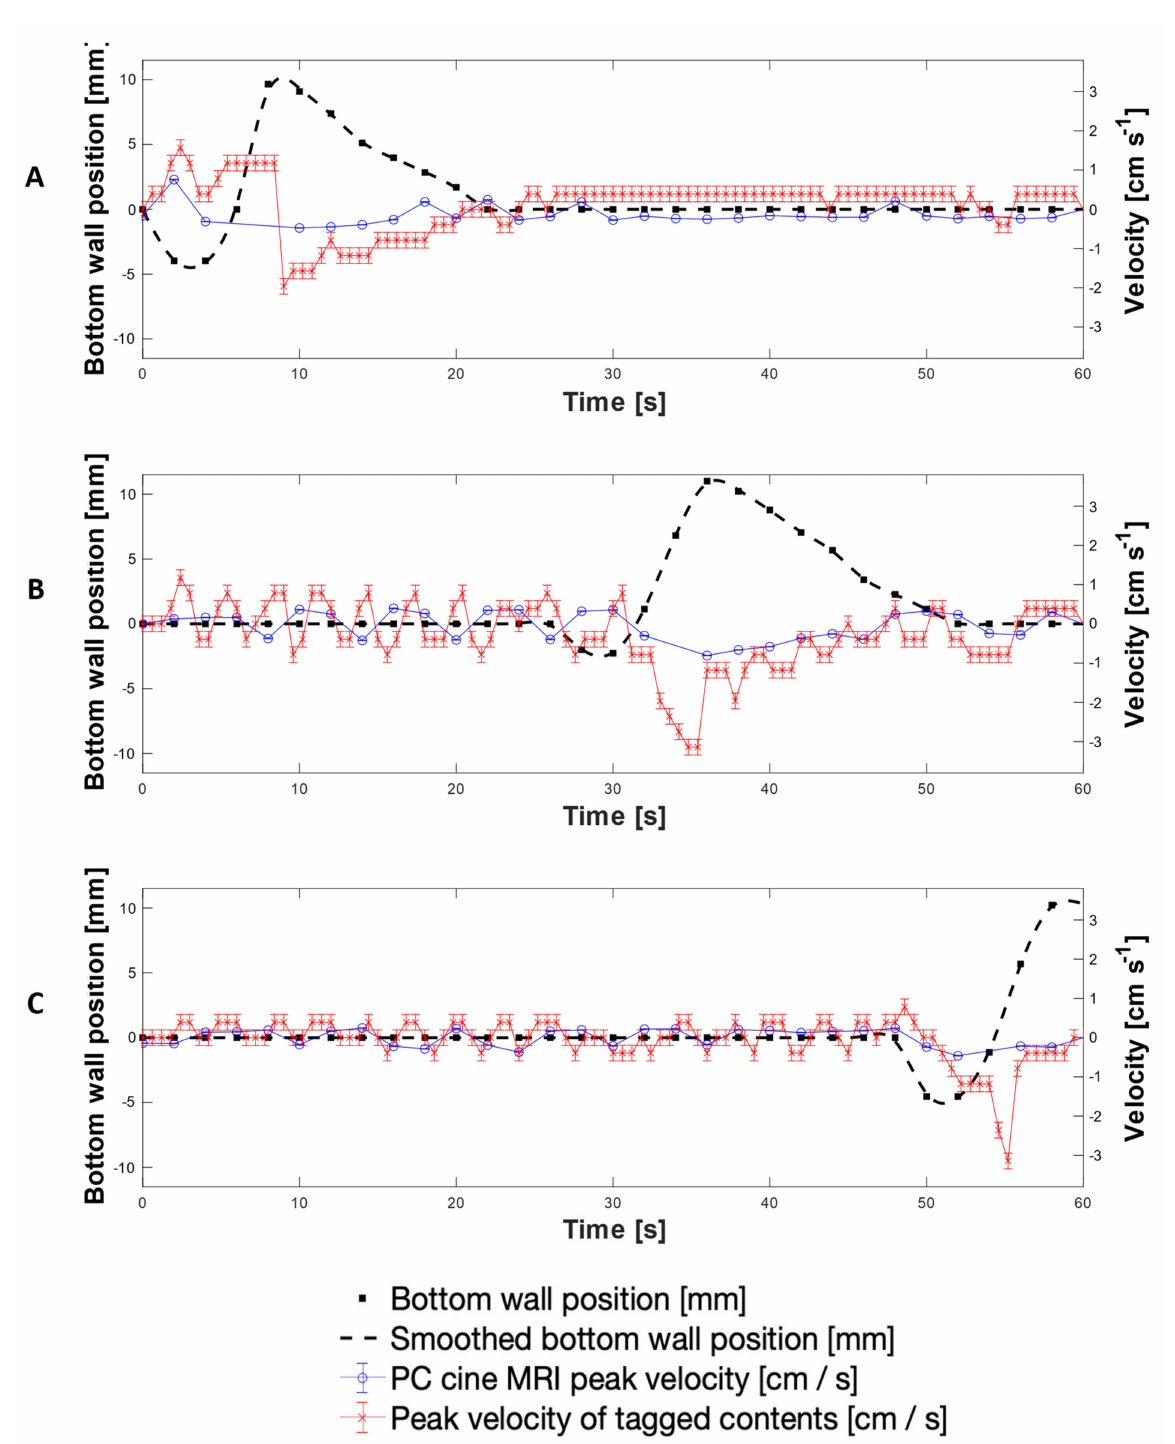
Figure 9. Peak velocities recorded using tagged and PC cine-MRI at the location of tags 3 ( A ), 12 ( B ) and 19 ( C ), alongside wall displacement at the corresponding location (dashed